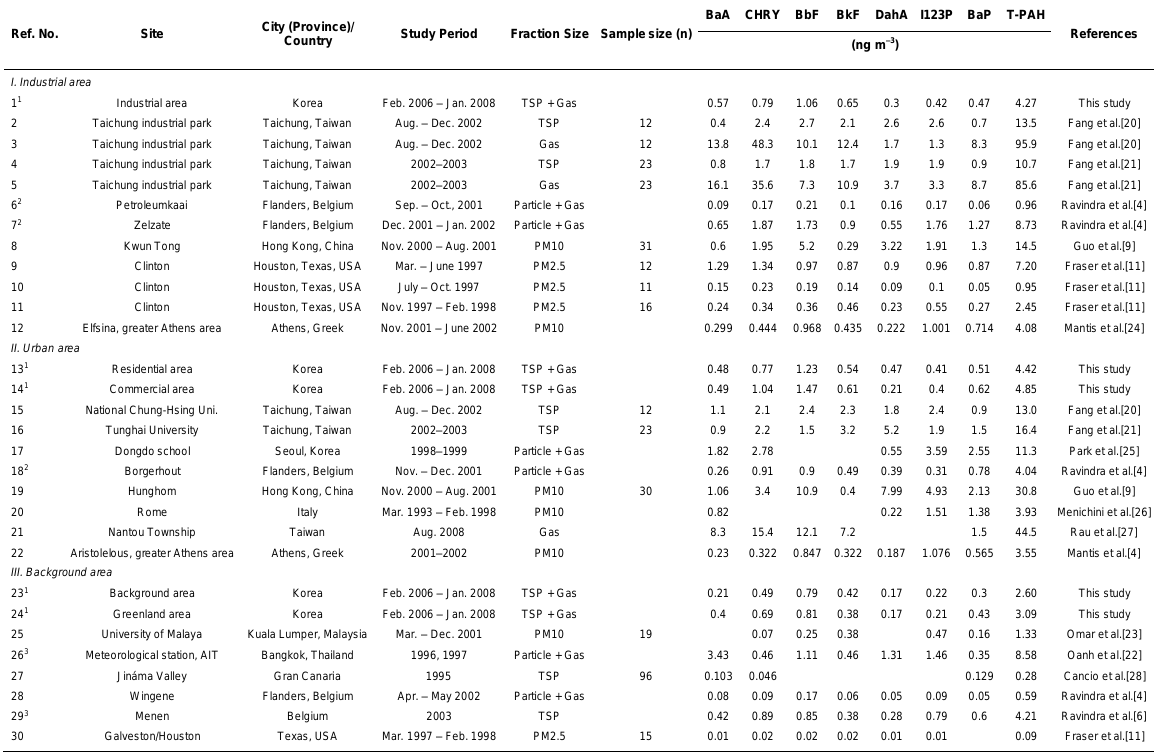
Comparison the PAH Concentration Data Measured in Industrial, Urban, and Background Areas on the Globe